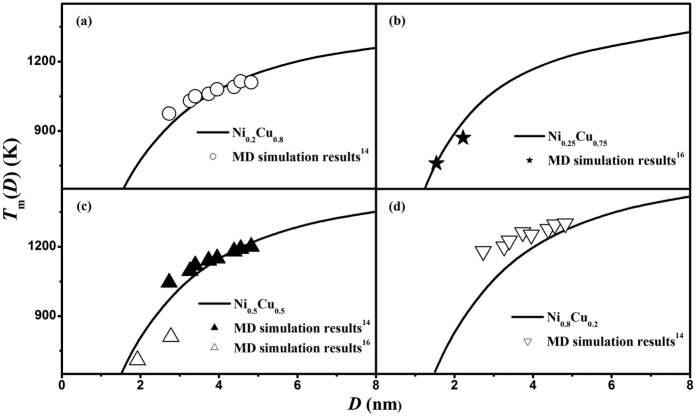
Comparisons of Tm(D) functions for (a) Ni0.8Cu0.2, (b) Ni0.75Cu0.25, (c) Ni0.5Cu0.5, and (d) Ni0.2Cu0.8 nanoparticles between the model predictions and available MD simulation results1416.